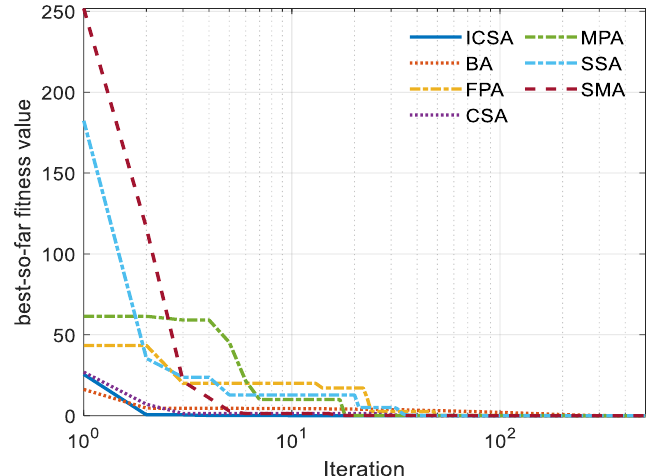
Figure 8. Convergence curve for F8.